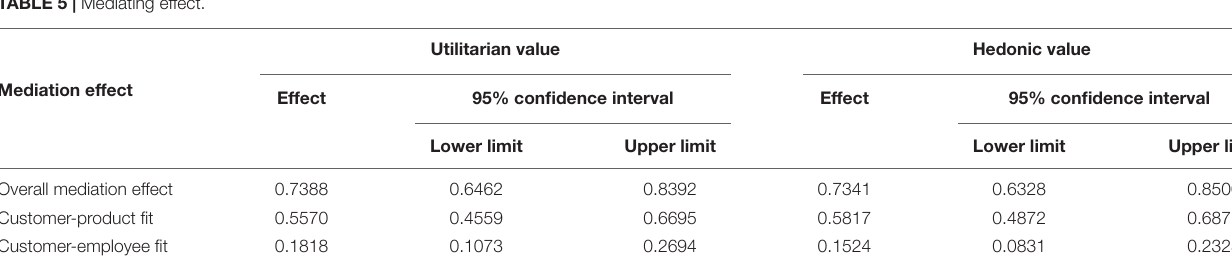
TABLE 5 | Mediating effect.